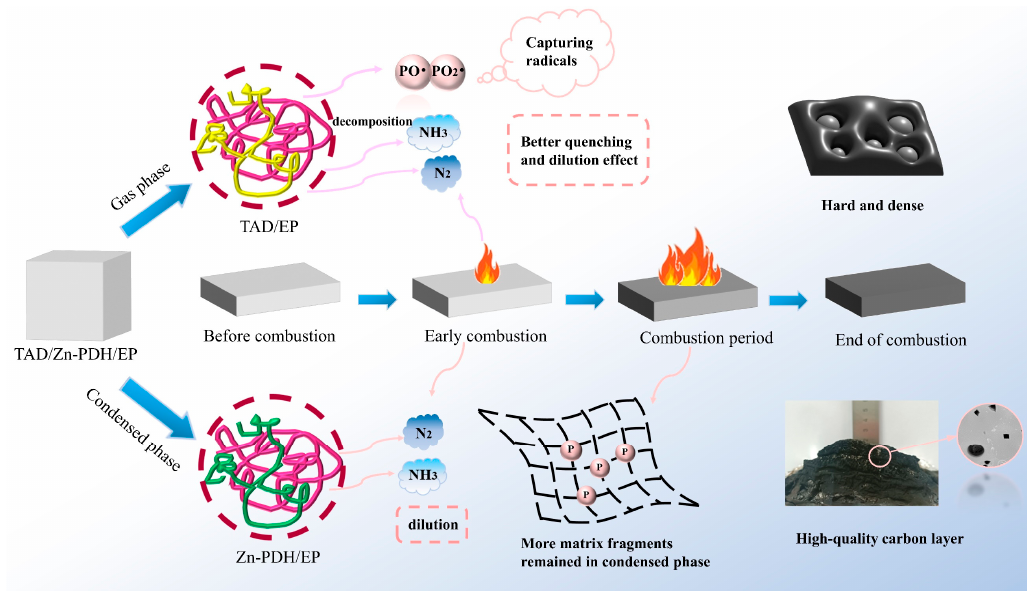
Figure 10. Flame retardant modes of action of TAD/Zn-PDH in EP.